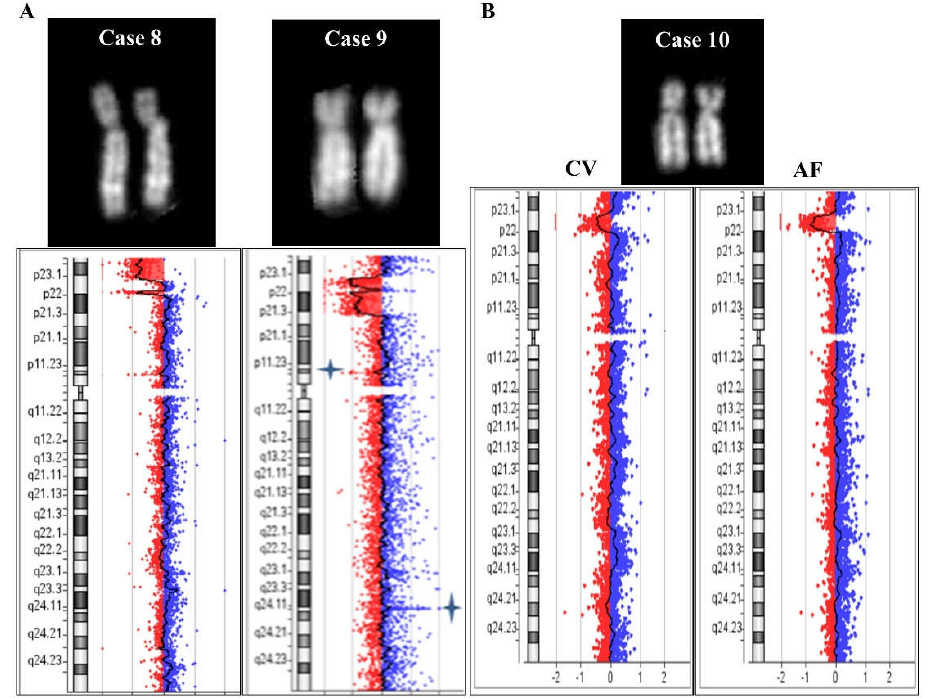
Figure 5. Cases 8, 9, and 10. ( A ) QFQ-banded chromosome 8 for cases 8 (left) and 9 (right), with the corresponding array CGH ideograms below. ( B ) QFQ-banded chromosome 8 of case 10 obtained from spontaneous metaphases of cytotrophoblasts. Array CGH results on chorionic villi (CV, left) and amniotic fluid (AF, right). No conventional cytogenetics were performed on amniotic fluid. Case 9: Prenatal diagnosis required because of positive first trimester combined test.